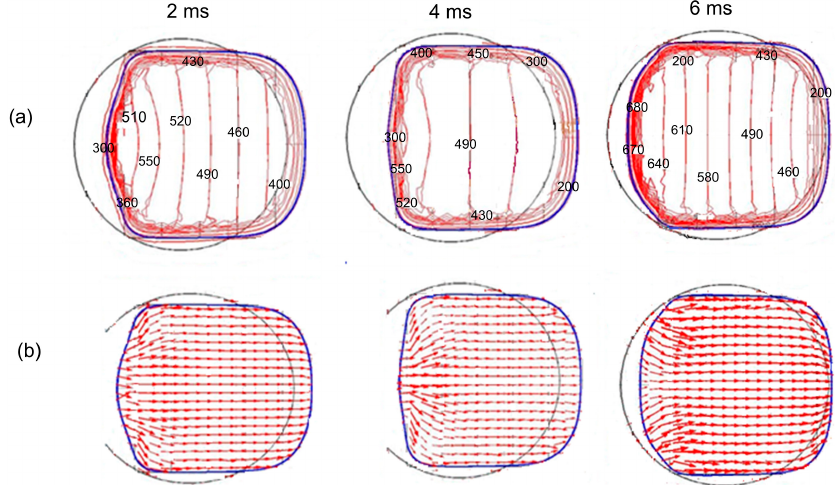
Figure A4. ( a ) Pressure distribution inside droplet on slender electrodes (S L 5) from simulation (pressure contours in MPa); ( b ) velocity field inside droplet from simulation (interface shown in blue and initial droplet shape is shown in black).